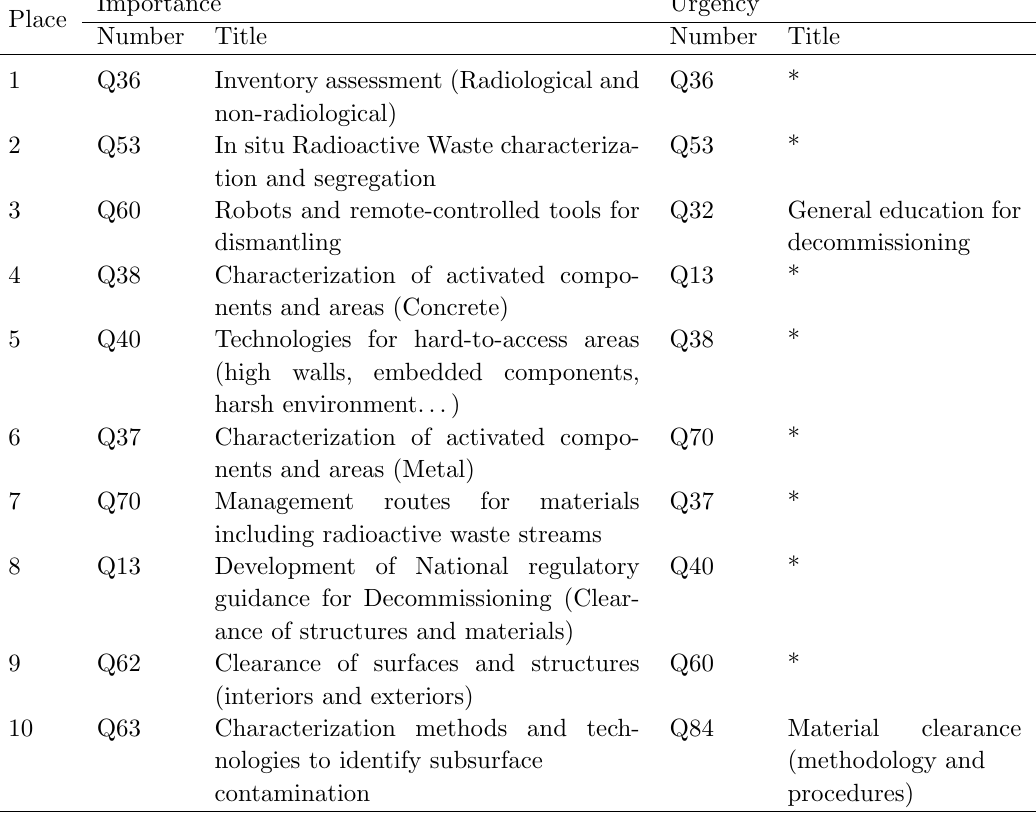
Table 1. Top 10 subthematic areas in terms of importance and urgency.